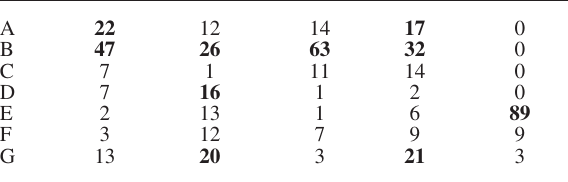
Table 2. – percentage distribution of the recorded fishing trips of the seven boat seine identified landings profiles in each main geographical area of the aegean Sea. For each area, the landings profiles with a contribution >15% are given in bold.